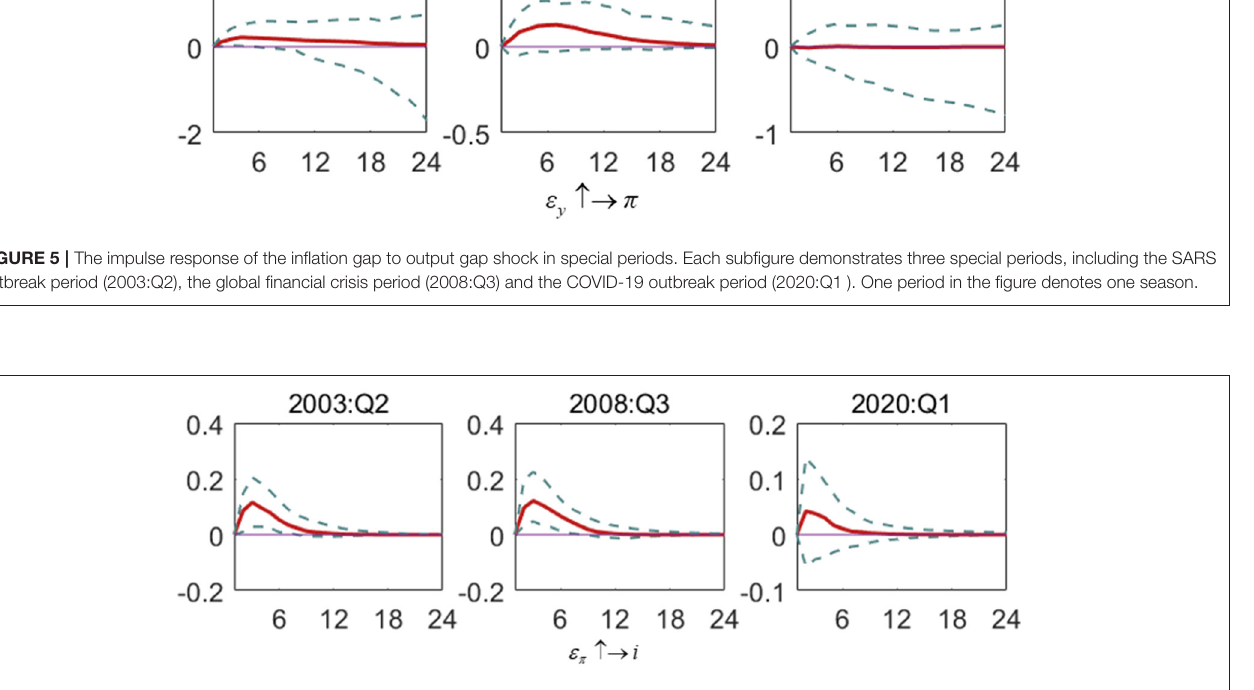
FIGURE 6 | The impulse response of the interest rate to inflation gap shock in special periods. Each subfigure demonstrates three special periods, including the SARS outbreak period (2003:Q2), the global financial crisis period (2008:Q3) and the COVID-19 outbreak period (2020:Q1 ). One period in the figure denotes one season.